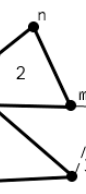
Figure 2. Finite element contact scheme.